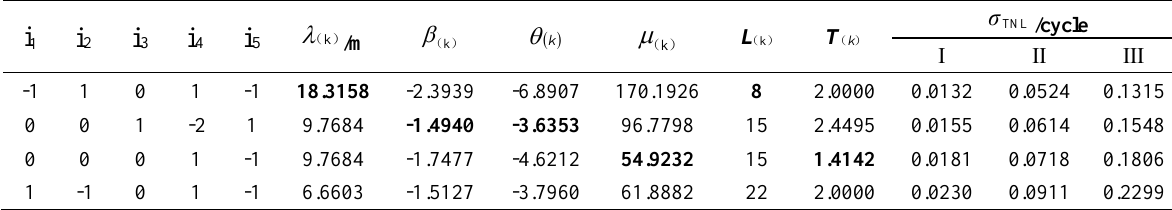
Table 5. Optimal combinations and parameters of BDS-3 five-frequency signals